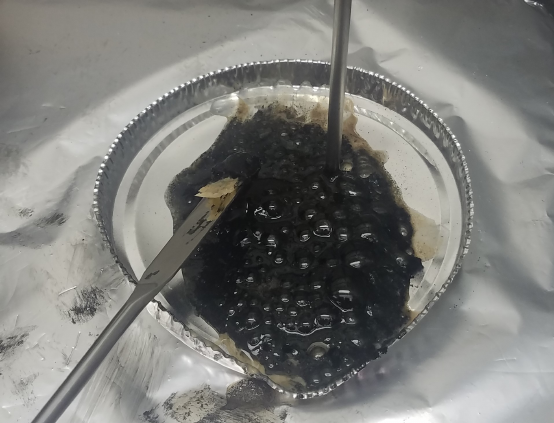
Figure A1. Reaction of 80:20 PHBV:PLA with BioC. Reaction occurs in close proximity to the melting